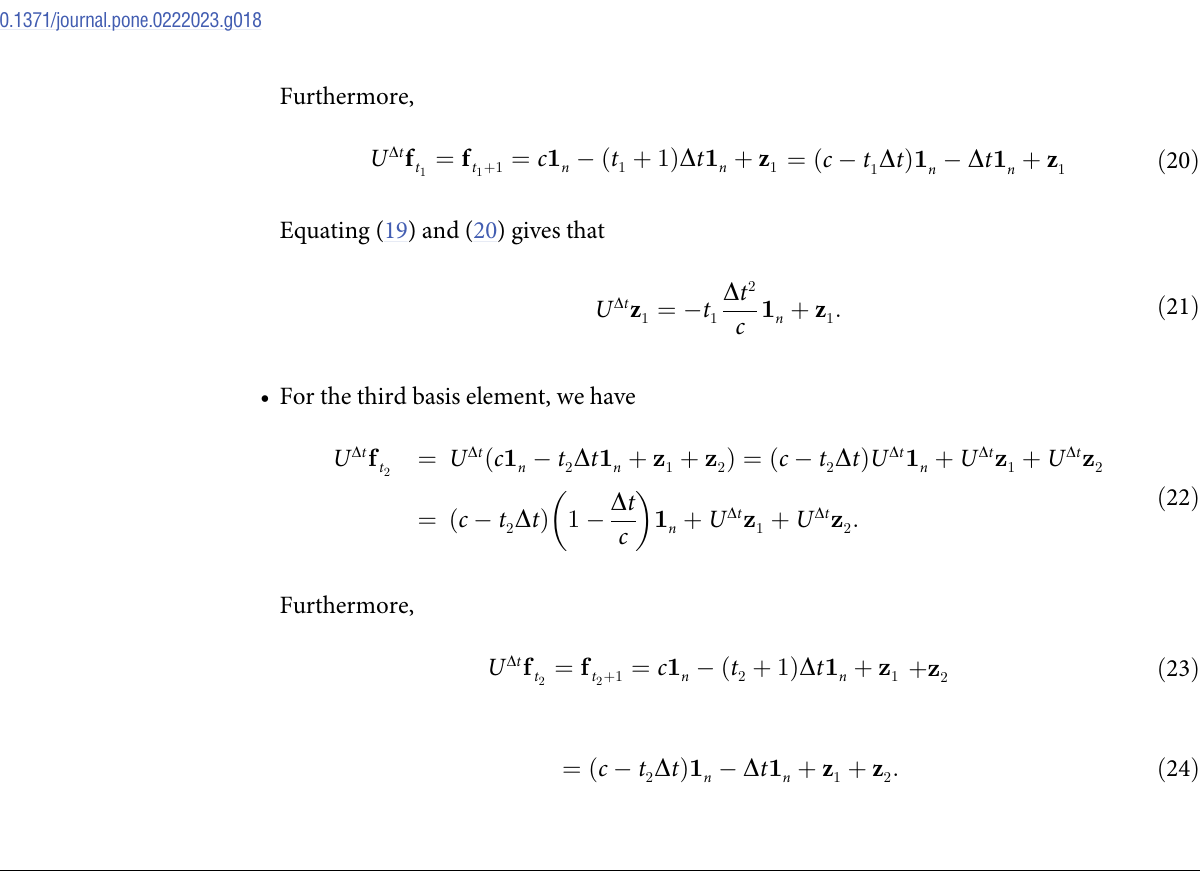
Fig 18. Eigenvalues of the dominant mode for each simulation for each initial fuel value. The eigenvalue color scale (blue to red) shows the L-2 norm of each eigenvalue’s associated Koopman mode. The dominant mode eigenvalues mostly represent the mean of the site fuel values and do not depend strongly on maximum site fuel